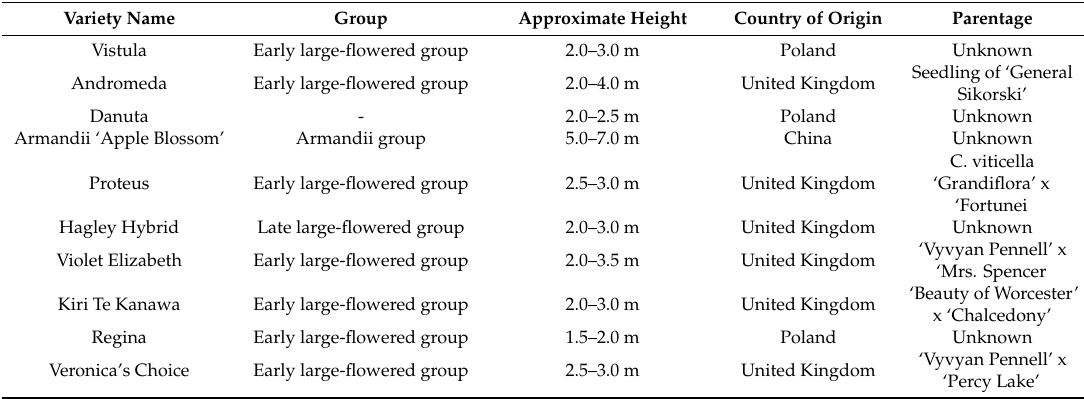
Table 1. Information of Vistula, Andromeda, Danuta, Armandii ‘Apple Blossom,’ Proteus, Hagley Hybrid,